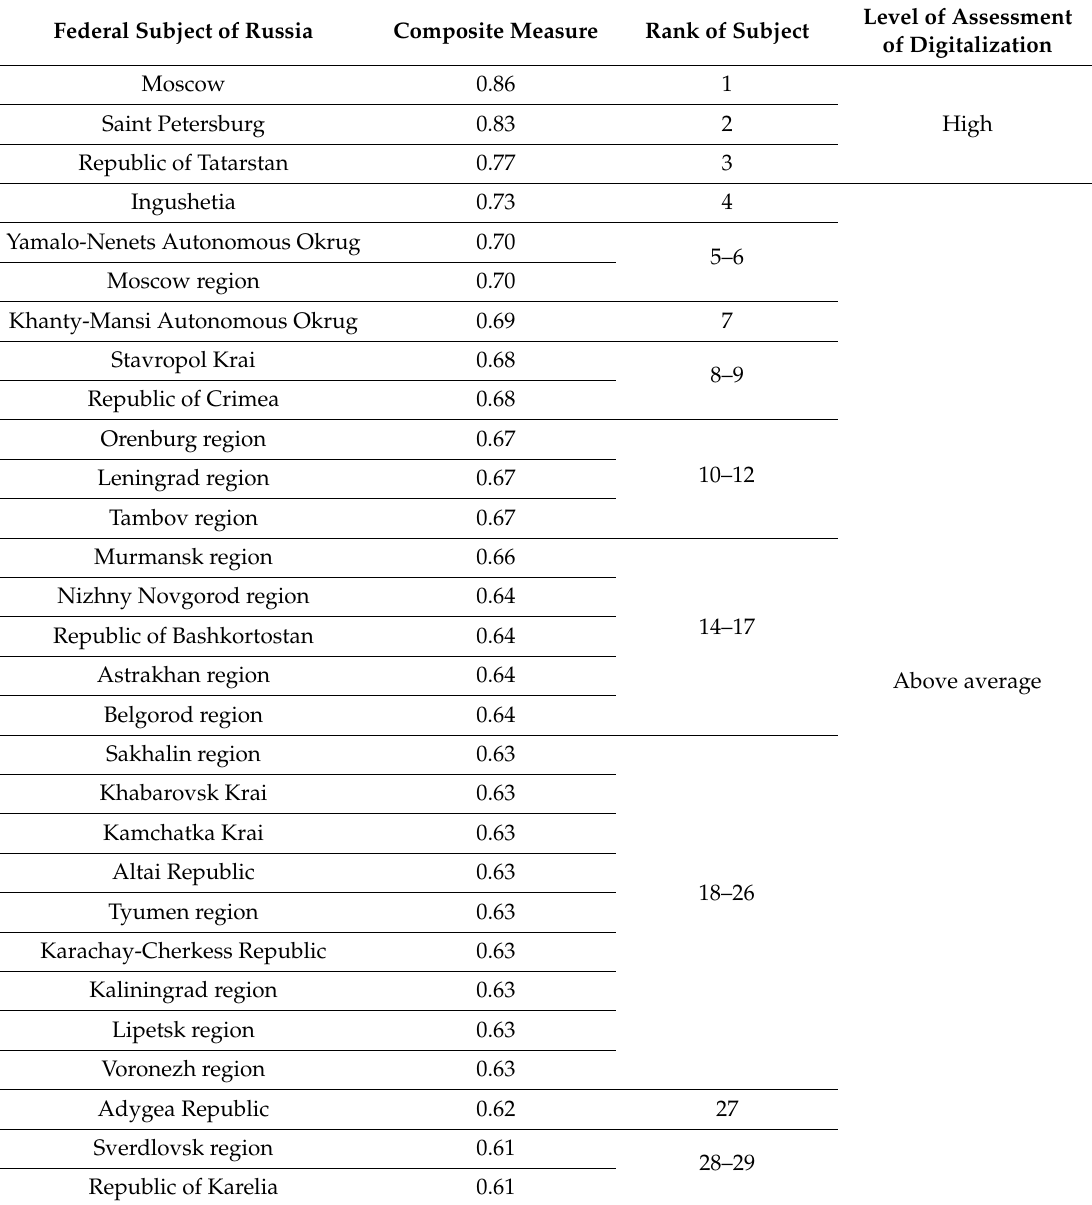
Table 6. Results of assessment of digitalization levels in federal subjects of Russia in